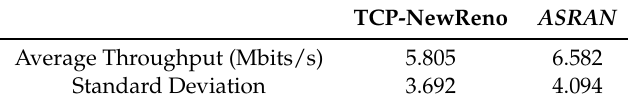
Table 3. Average throughput comparison of simulation experiment.